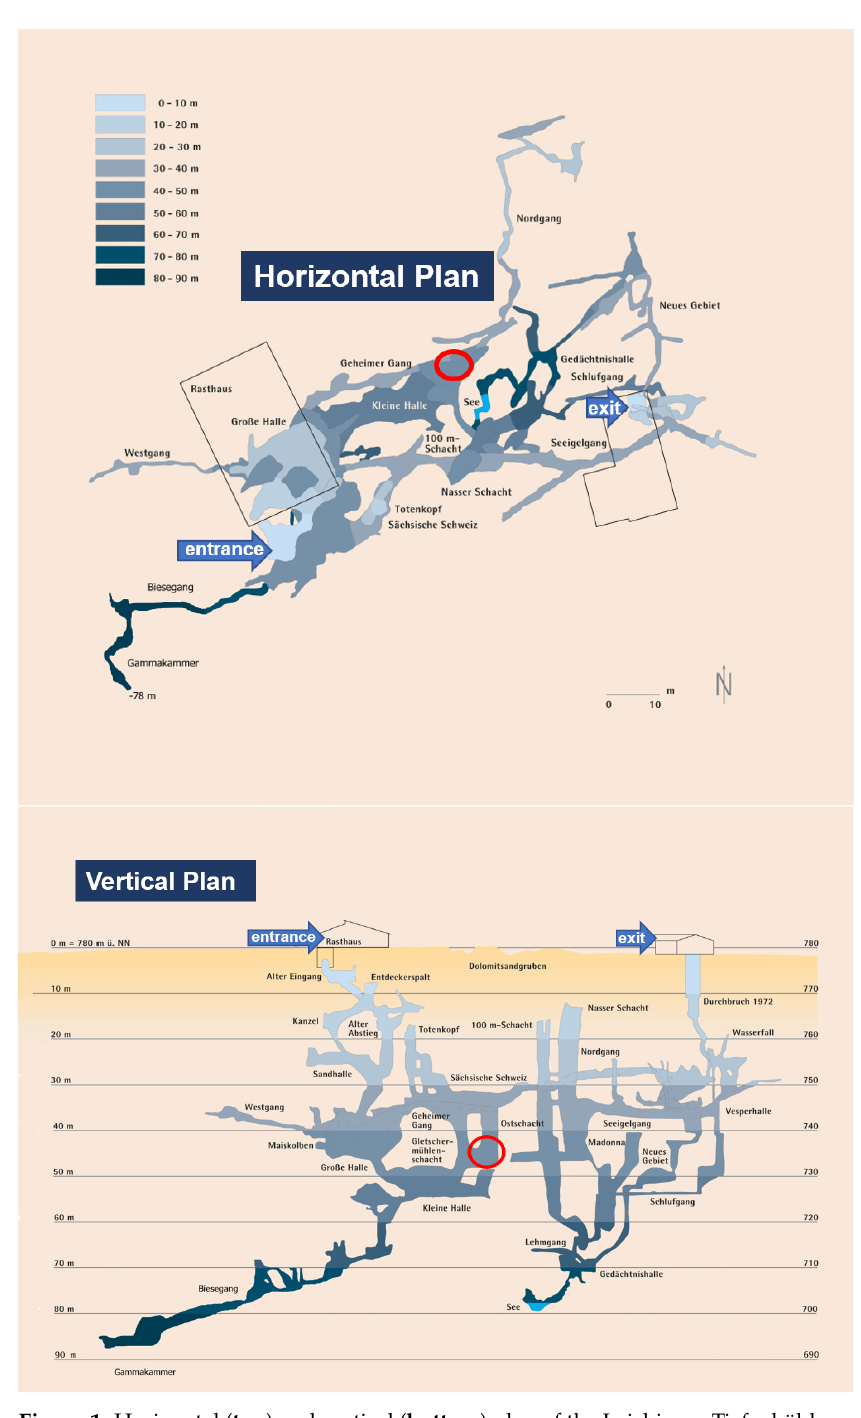
Figure 1. Horizontal ( top ) and vertical ( bottom ) plan of the Laichinger Tiefenhöhle cave. Courtesy of Höhlen- und Heimatverein Laichingen. Colour shadings indicate depth below ground surface. Red ellipses mark the location of the experimental